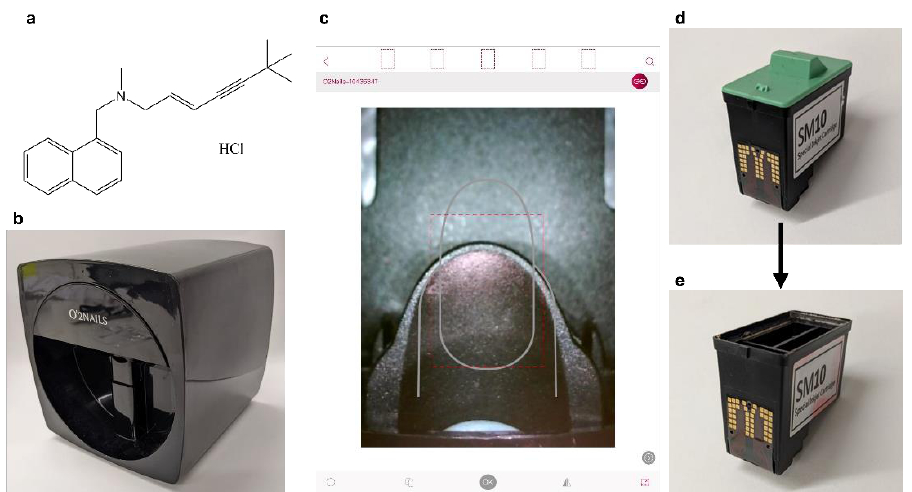
Figure 1. ( a ) Chemical structure of terbinafine HCl, the active pharmaceutical ingredient. ( b – e ) Images of the O2Nail V11 nail printer. ( b ) Picture of the nail printer. ( c ) Image of the nail printing app, taken from the iPad screen. The display is from the in-printer camera. ( d ) Picture of the SM10 Inkjet cartridge, with the lid on. (e) Picture of the ink cartridge, after removing the lid and cleaning out the commercial inks. This cartridge can then be loaded with an in-house prepared solution for printing.